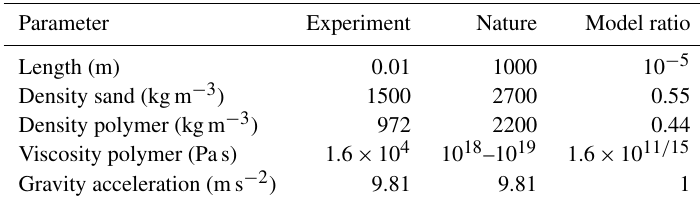
Table 1. Scaling parameters used in the experimental programme.